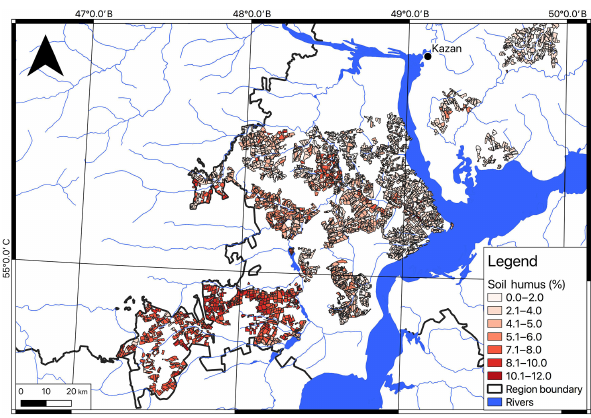
Figure 1. Distribution of humus content of soil on the example of west part of